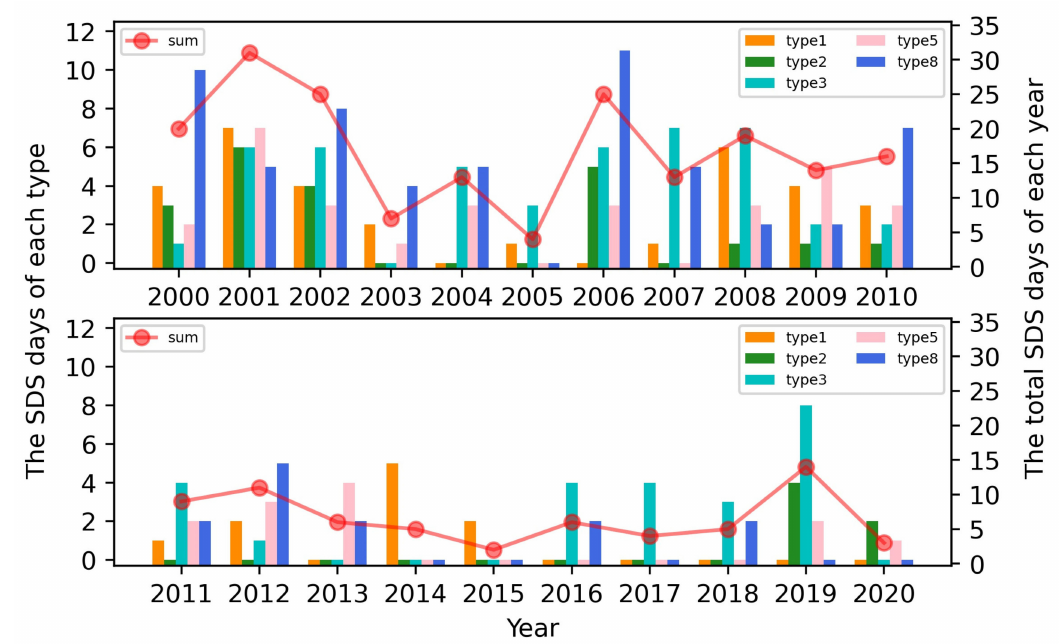
Figure 7. Annual distribution of the number of SDS days under the dominant circulation